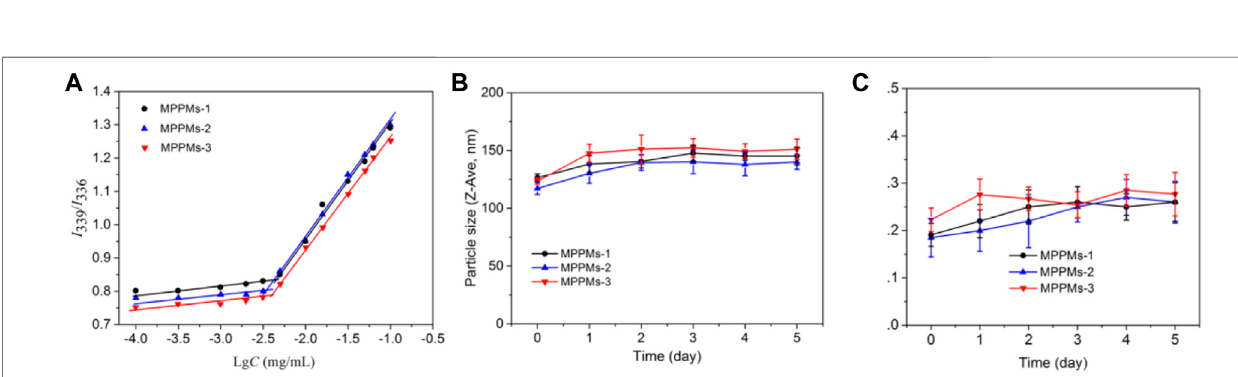
TABLE2| TheIC50valuesofthreeMPPMsagainstA549andMDA-MB-231cells. Cell